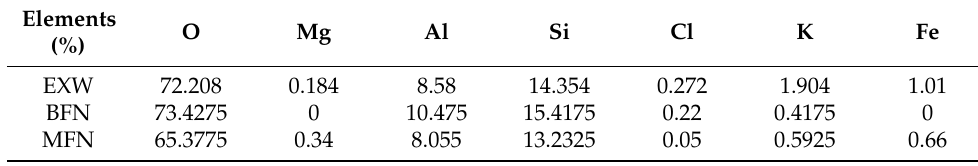
Table 7. EDS average elemental results from 28 spectra each.